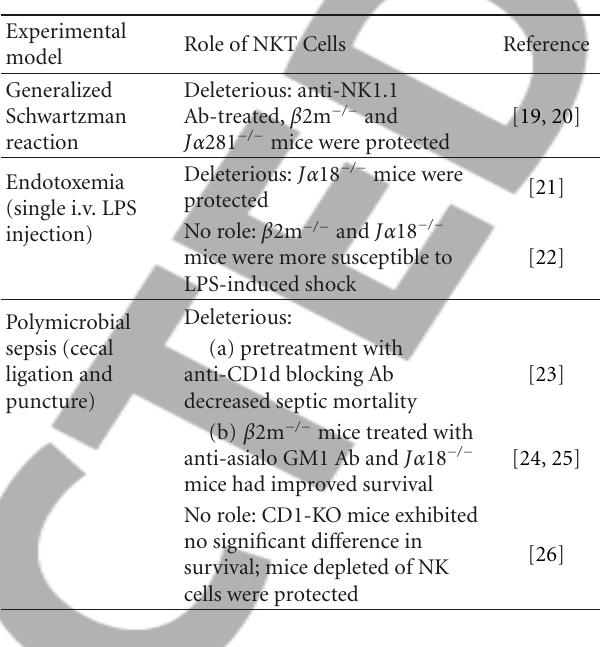
Table 1: Summary of proposed role of NKT cells in experimental models of